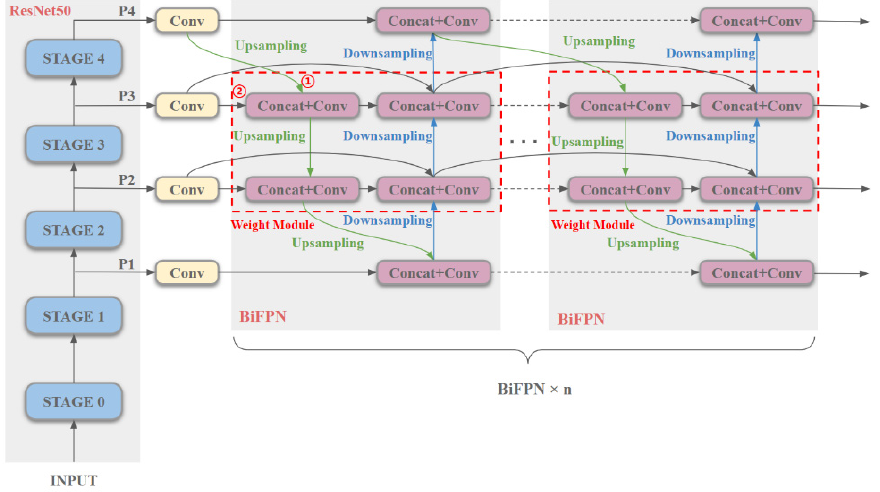
Figure 4. Implementation of ResNet-BiFPN.